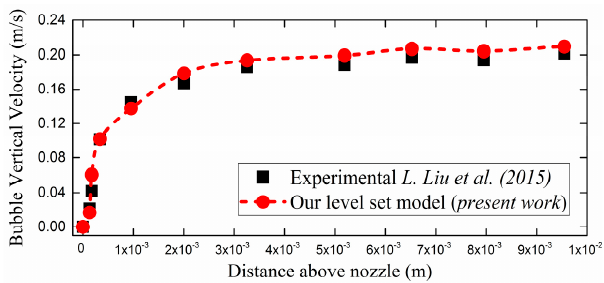
Figure 5. Comparisons between vertical velocities of a 2.77 × 10 − 3 m air bubble at different heights above the bottom nozzle that released the air bubble into the water column obtained experimentally [48] (squares) and from the present model (circles).